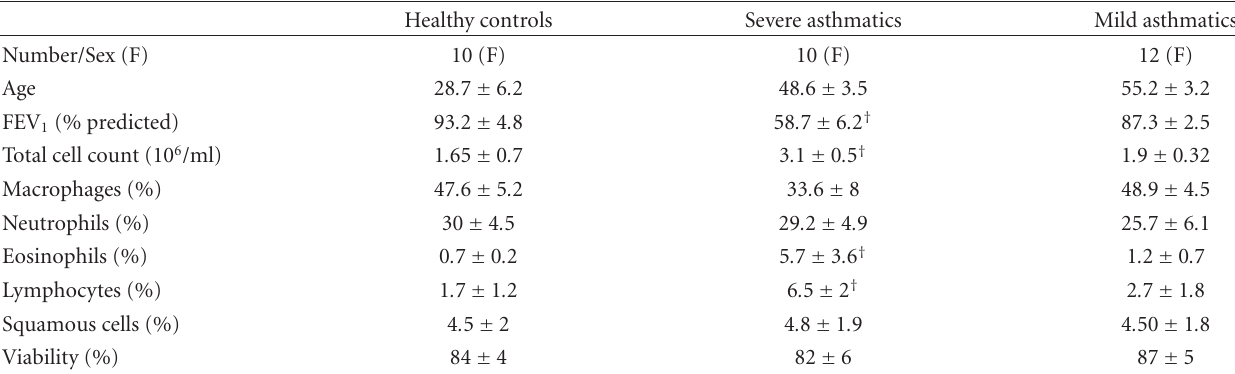
Table 1: Cellular characteristics of induced sputum. Di ff erential sputum cell counts are expressed as percentage of nonsquamous